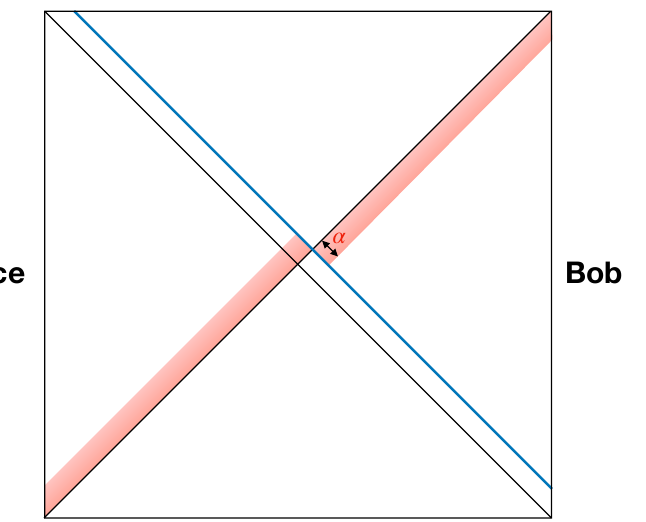
Figure 7 . Bob is sitting at the South pole of de Sitter space and creates a positive energy shockwave (blue). As a result, Alice can send a message (red) to Bob at the North